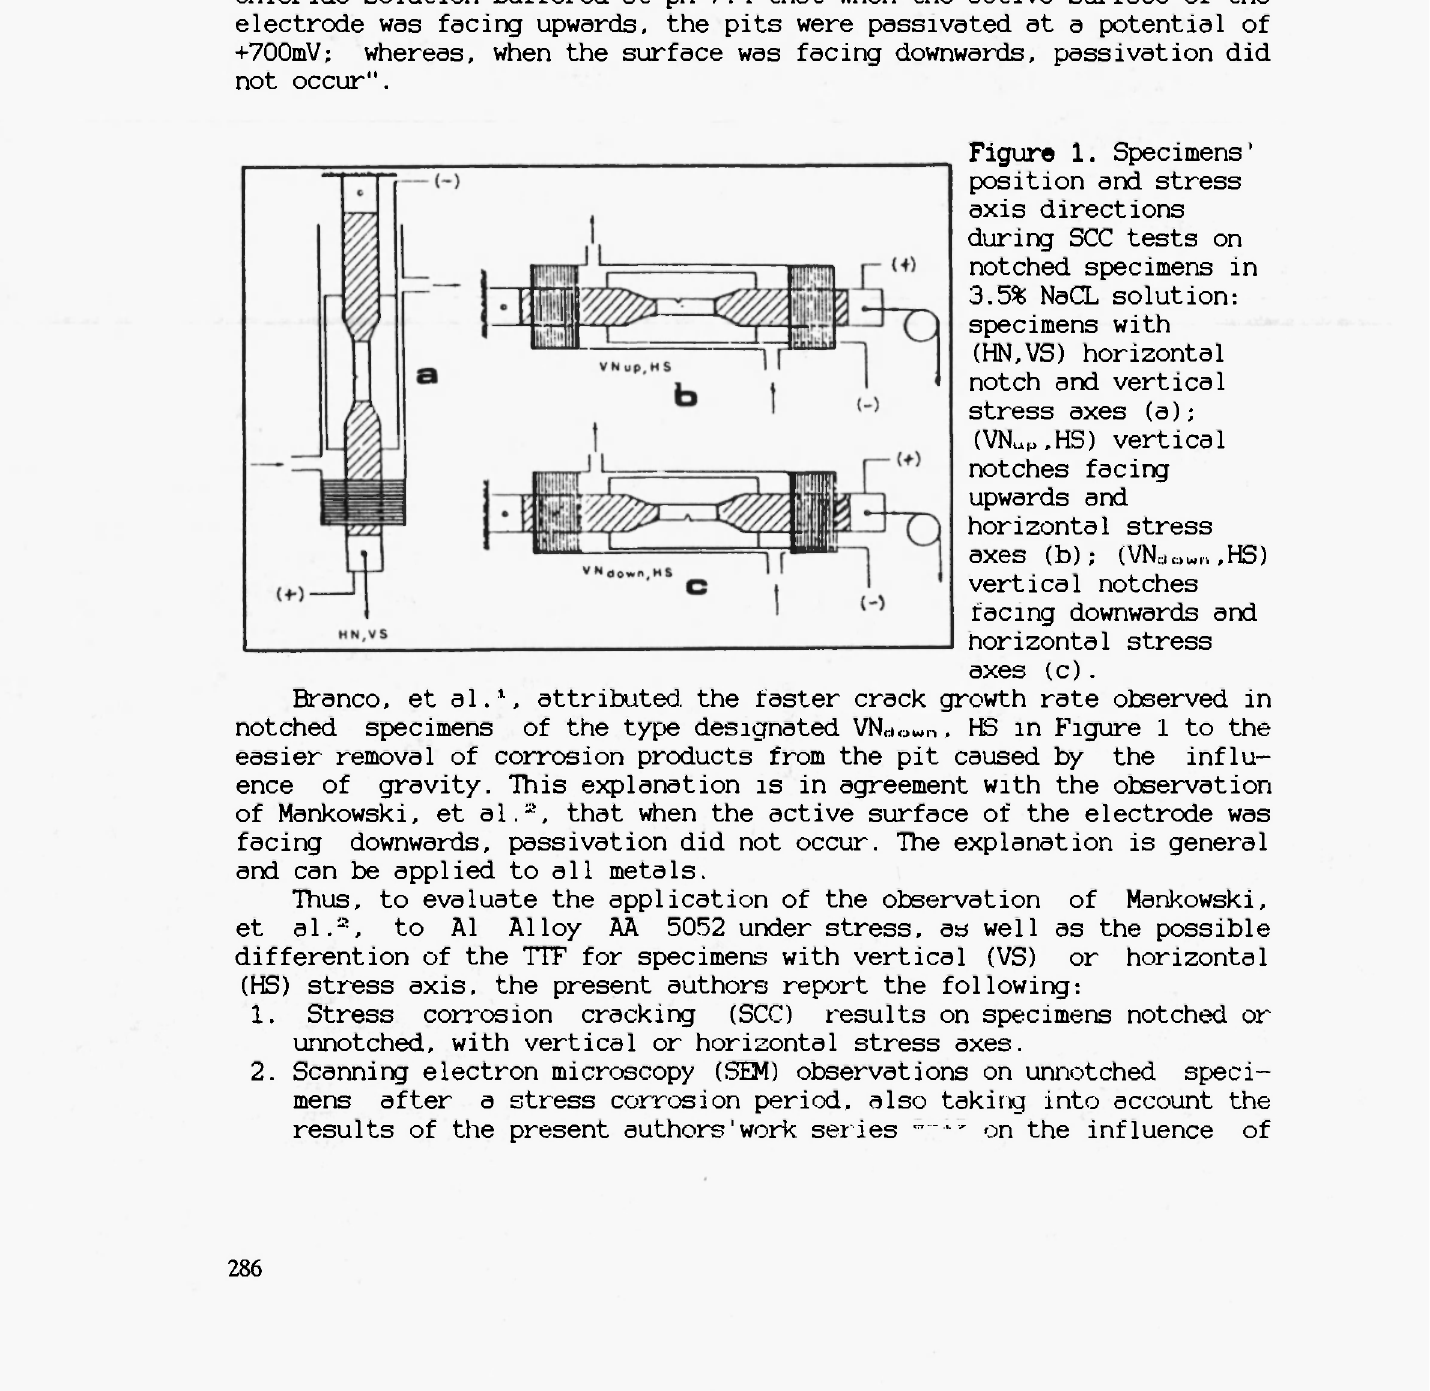
position and stress axis directions during SCC tests on notched specimens in 3.5% NaCL solution: specimens with (HN,VS) horizontal notch and vertical stress axes (a); (VNup.HS) vertical notches facing upwards and horizontal stress axes (b); (VNd»««,HS) vertical notches facing downwards and horizontal stress axes